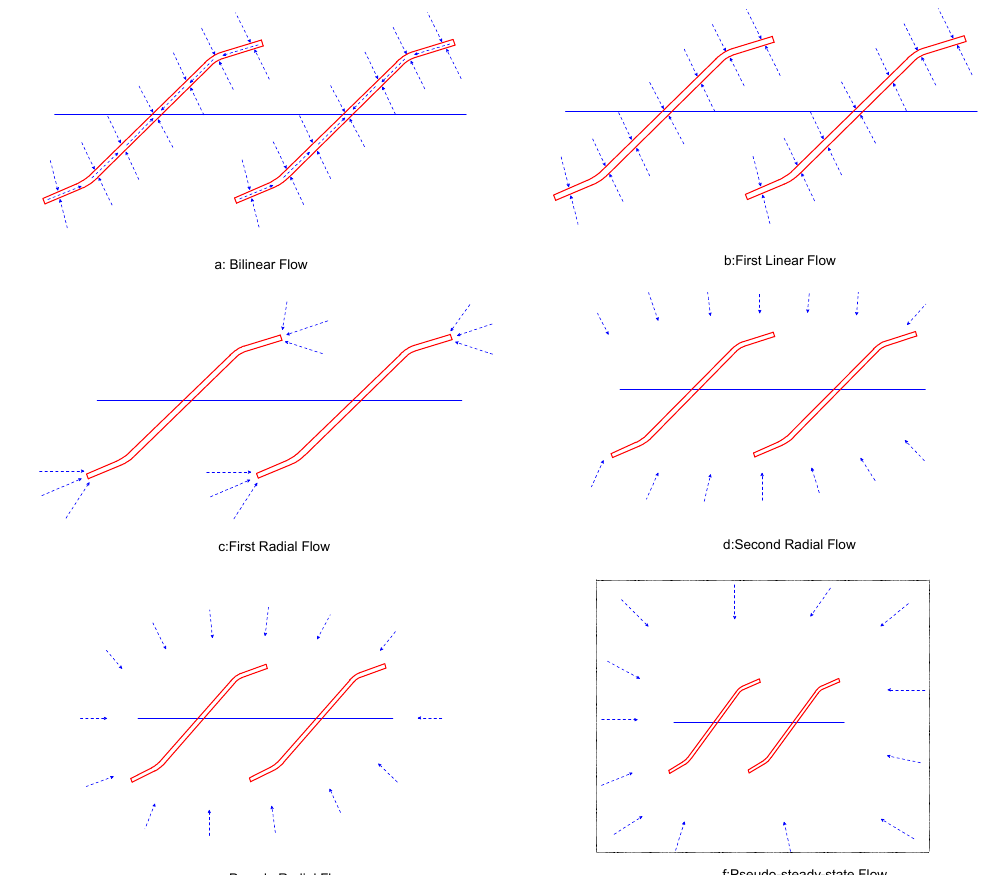
Figure 7. Schematic of the flow regimes for a horizontal well with two reorientation fractures: ( a ) Bilinear flow regime; ( b ) First linear flow regime; ( c ) First radial flow regime; ( d ) Second radial flow regime; ( e ) Pseudo radial flow regime; ( f ) Pseudo-steady-state flow regime.